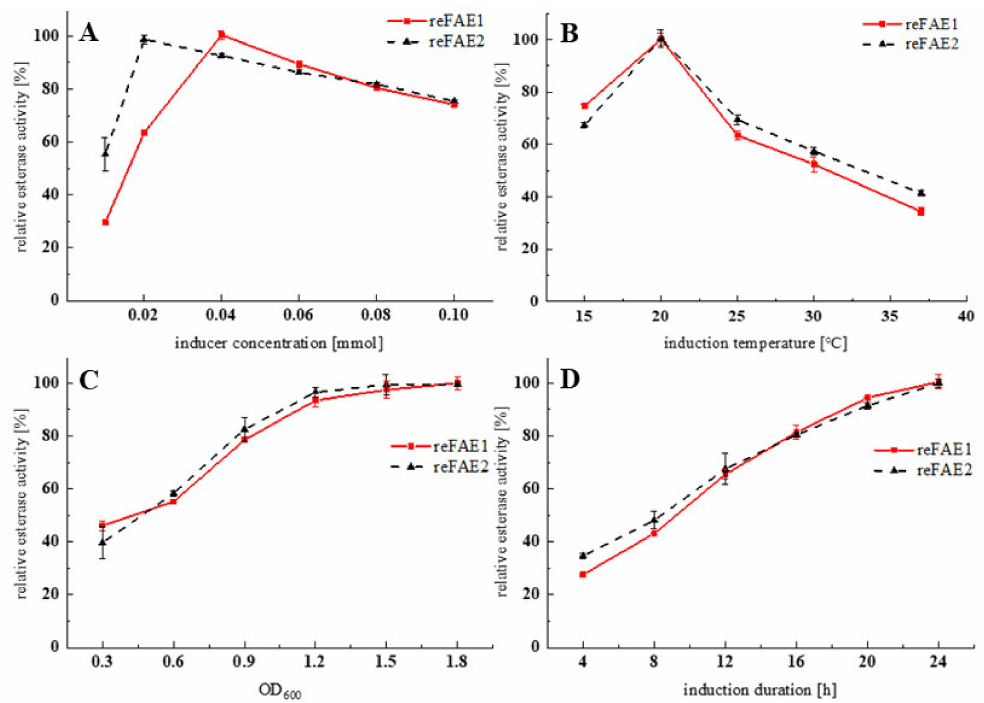
Figure 2. Optimization of induction conditions. ( A ) Optimal inducer concentration of reFAEs; ( B ) optimal induction temperature of reFAEs; ( C ) optimal OD 600 value of reFAEs; ( D ) optimal induction duration of reFAEs.